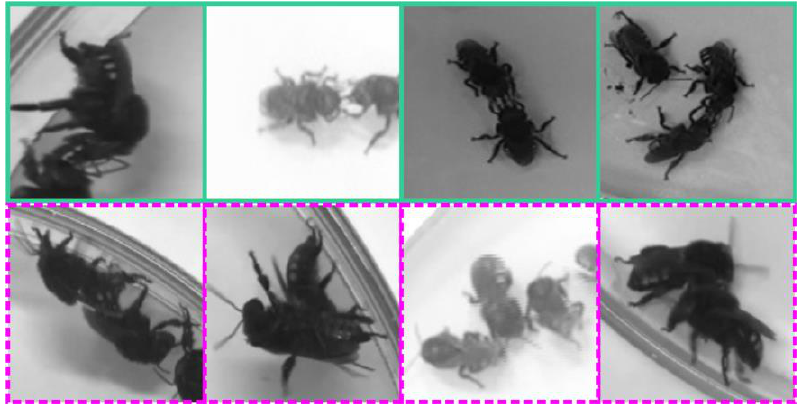
Figure 6. Examples of images that were automatically labeled with our heuristic to train the CNN model to recognize trophallaxis in the stingless bee Melipona quadrifasciata . The images with green outlines ( top ) are examples of trophallaxis. The images with dashed purple outlines ( bottom ) are examples of non-trophallaxis.